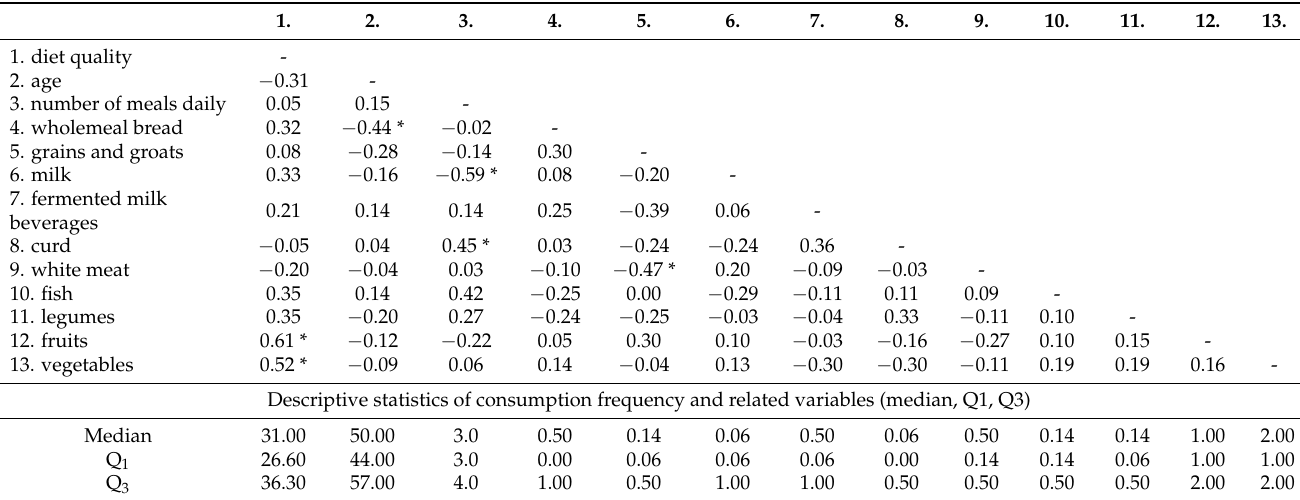
Table 4. Determinants of diet quality of masters athletics from Great